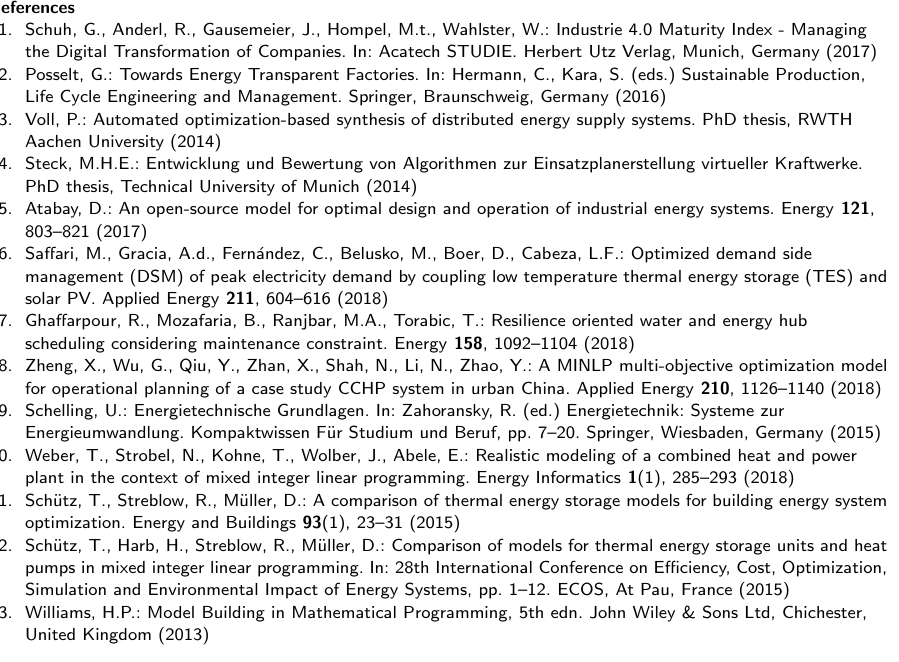
use cases. The validation shows that the MILP-MPC approach is able to keep a simulation model stable. Moreover, it optimizes temperatures in the thermal grids due to the variety in electricity prices. Thus, the approach manages to reduce energy costs compared to a typical rule based controller. In future work, the parameters should be further trained on real data sets so that the approach can be tested in real